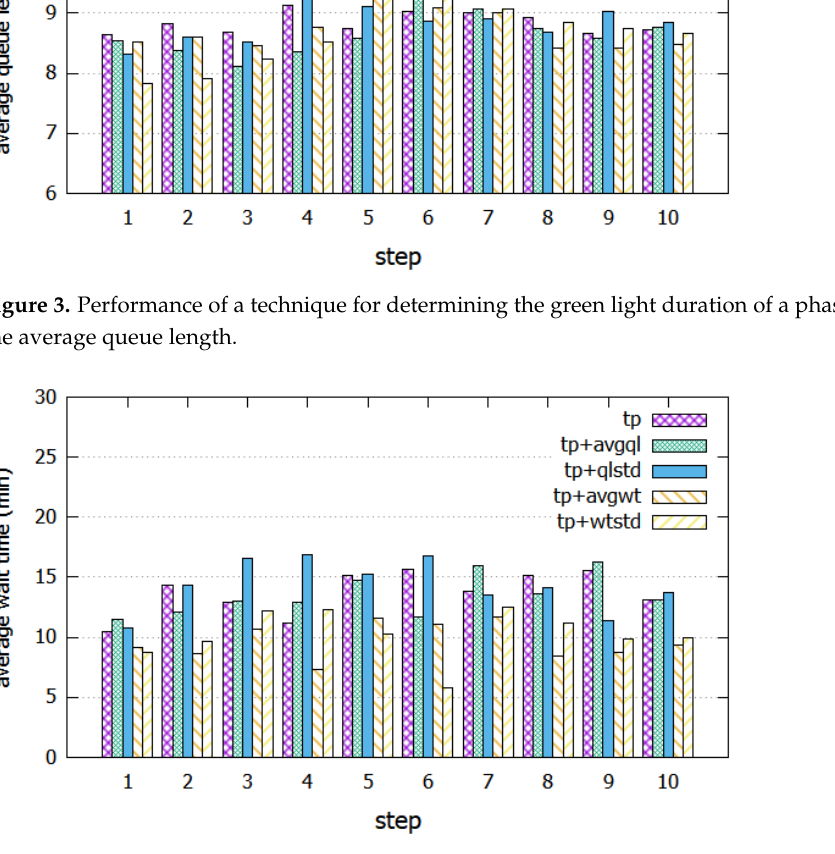
Figure 4. Performance of a technique for determining green light duration of a phase in terms of the average wait